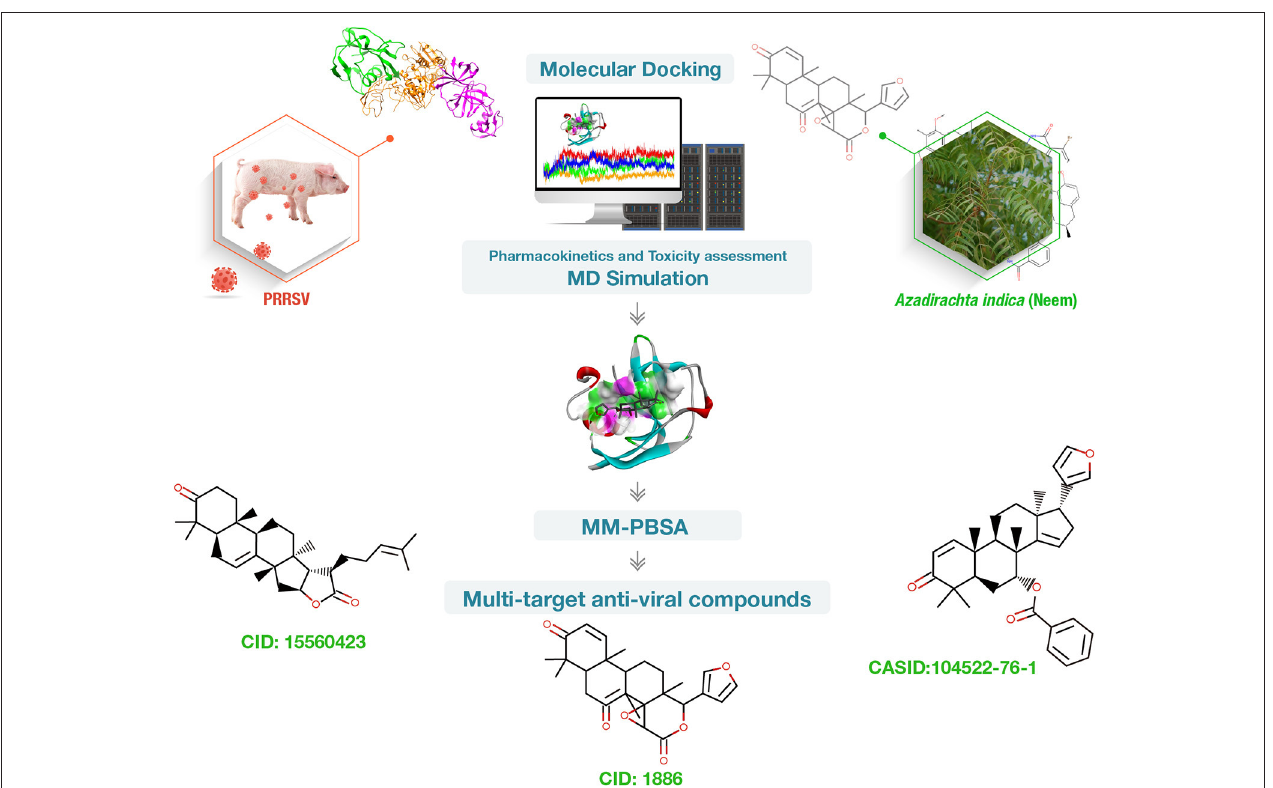
FIGURE 1 | Summary of the work conducted to find phytochemical-based multi-target inhibitors of porcine CD163 scavenger receptor cysteine-rich domain 5 (CD163-SRCR5), non-structural protein 4 (Nsp4), and Nsp10 essential for porcine reproductive and respiratory syndrome virus (PRRSV) infection. Vetinformatics approaches were